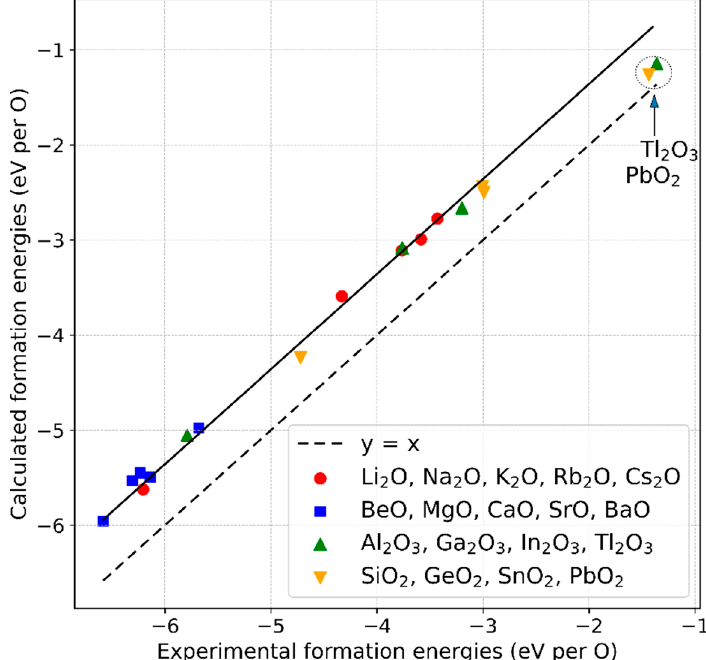
Figure 1. Comparison between formation energies derived experimentally (standard enthalpies of formation) and by density functional theory (DFT) calculations for a series of non-transition-metal oxides. The continuous line is a linear fit through the data points (excluding Tl 2 O 3 and PbO 2 ): 𝑦 = 𝑥 + 𝑏 , with 𝑏 = 0.64 eV/O. The dashed line is the identity line ( 𝑦 = 𝑥 ).